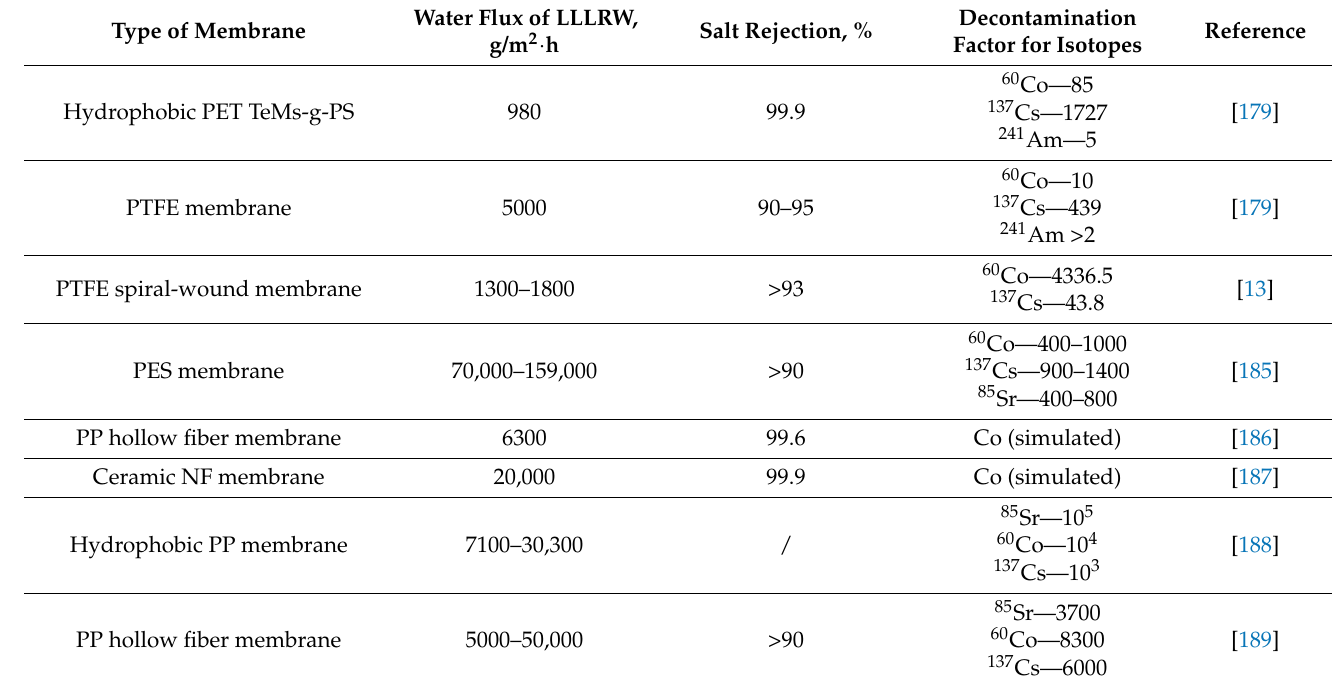
Table 5. A comparative analysis of the water flux, salt rejection and decontamination factor for some isotopes for different types of membranes used in LLLRW